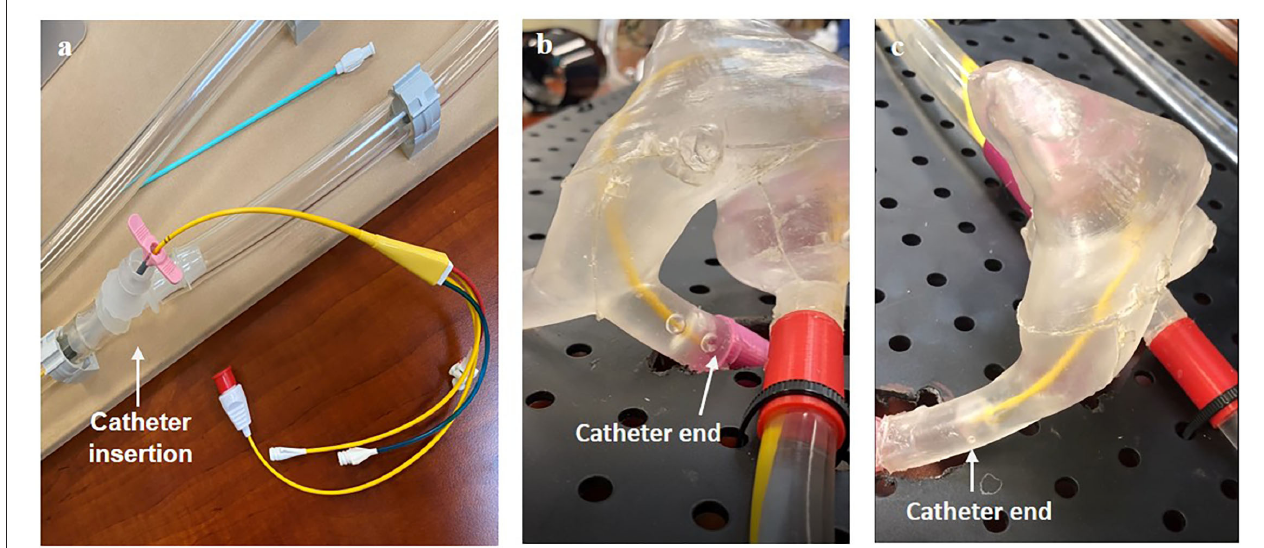
FIGURE 6 | Visual verification of catheter function including (a) the method of insertion and the catheter through the right side of the heart (b) from a radial insertion point and (c) from a femoral insertion